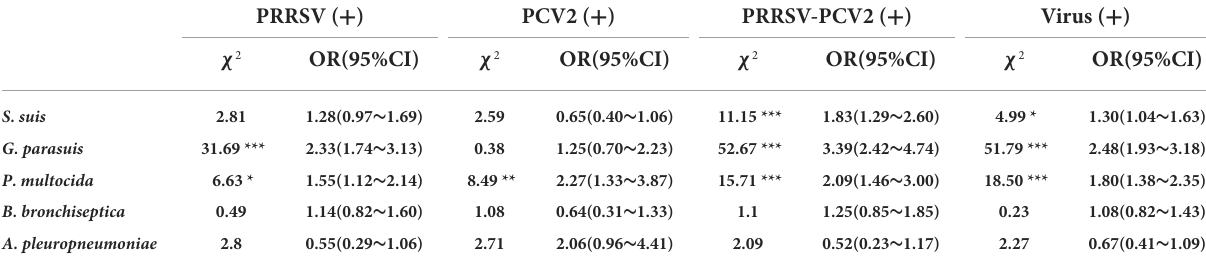
TABLE 3 Descriptive statistics and odds ratios for the detection of various bacteria under different immunosuppressive virus infections (compared with virus-negative). PRRSV ( + ) PCV2 ( +